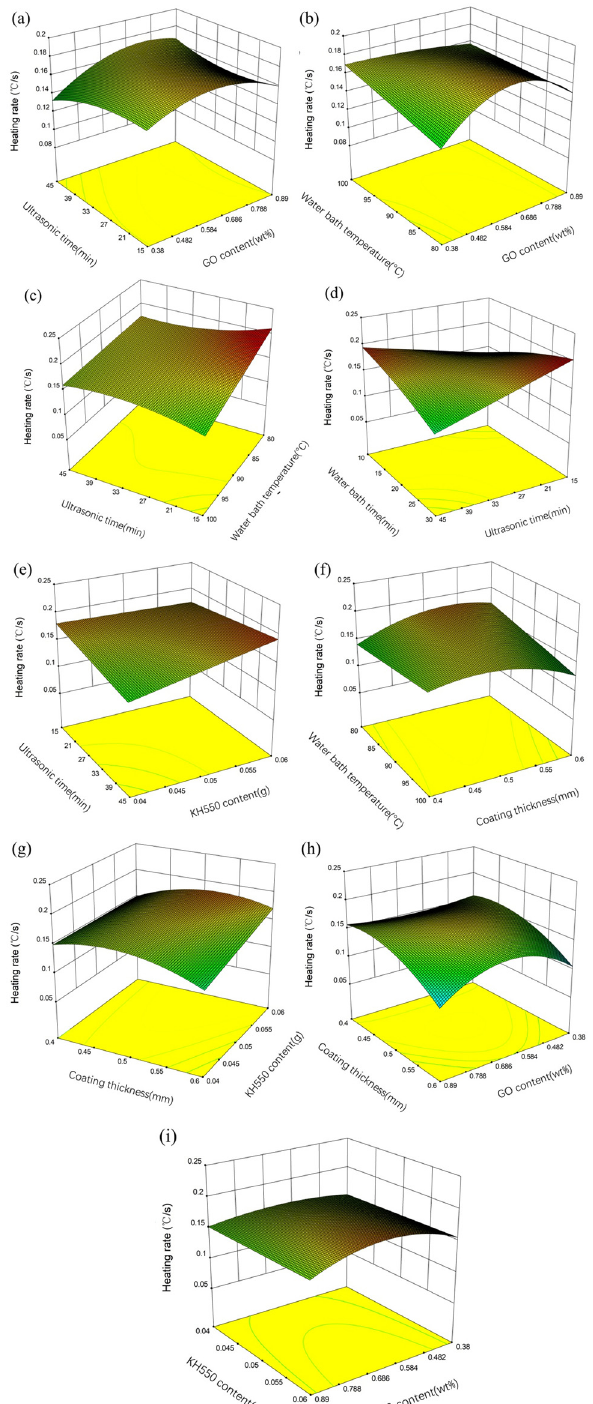
Figure 7: Response surface plots ( a ) – ( i ) showing interaction e ff ects of heating rate.